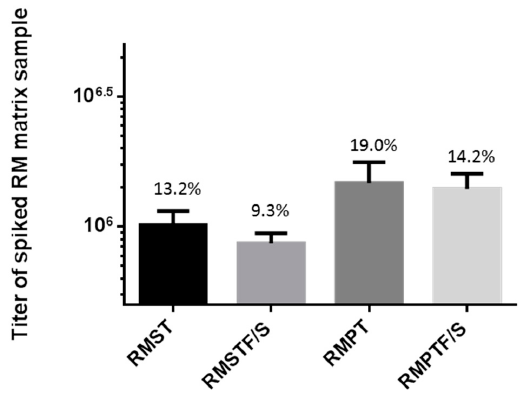
Figure 4. MARV ‐ spiked rhesus macaque serum and plasma can be titered after freeze ‐ thaw cycles. Rhesus Macaque Serum (RMST) and Plasma (RMPT) were subjected to three freeze ‐ thaw cycles of being held thawed at ambient temperature for at least 30 min and refrozen at − 60 °C or colder for no less than 20 h, on three consecutive days. Samples were titered in the plaque assay after the fourth thaw. There was little variability in each average titer, and a Student’s t ‐ test found a statistically ‐ significant difference ( p < 0.01) between RMST and RMSTF/S sample sets, yet the titers are acceptably similar; therefore, the difference is not biologically significant.